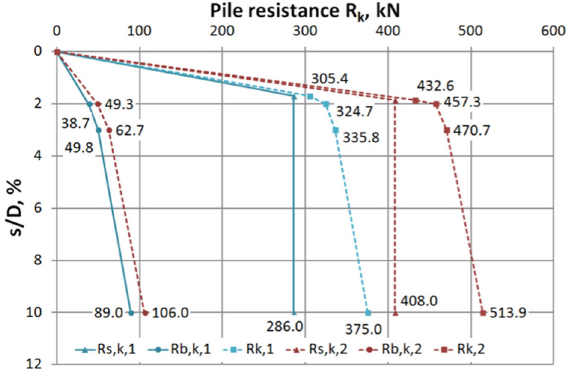
Fig. 8. Load bearing capacity according to the German Code DIN 1054